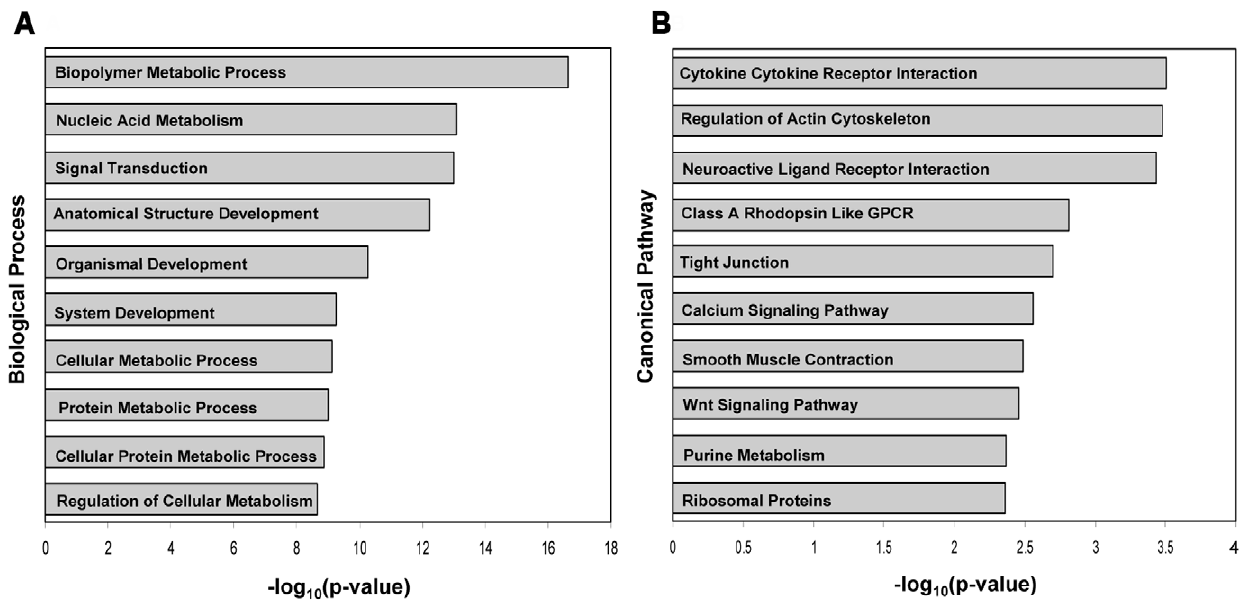
Figure 3. Gene Set Enrichment Analysis (GSEA) of biological processes and canonical pathways for differentially methylated genes. A) The top ten significantly enriched biological processes are displayed with their corresponding –log 10 (p-value). Multiple processes appear to be directly related to fetal heart development. B) The top ten significantly enriched canonical pathways are displayed with the corresponding 2 log 10 (p- value). Multiple pathways had previously been implicated in CHDs.